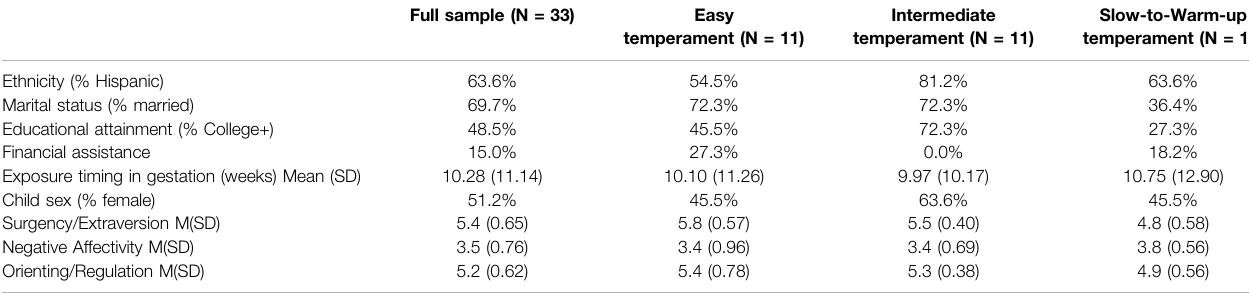
TABLE 1 | Exposure and demographic characteristics of the full sample and by temperament